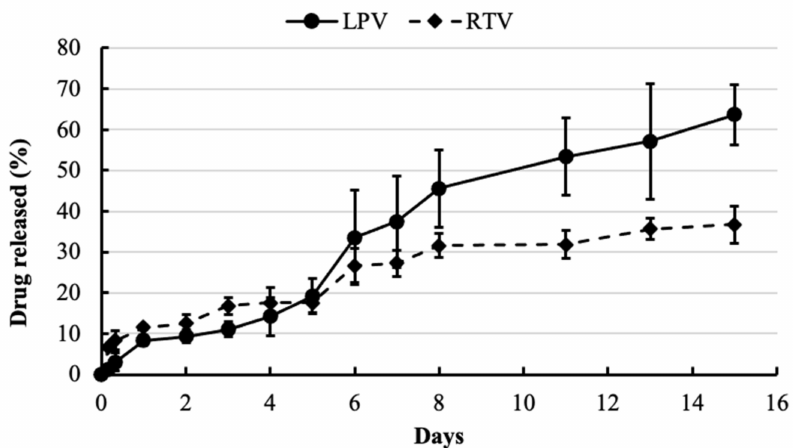
Table 2. RTV ( T 1/2 = 44.9 h) showed slower reduction of blood concentration compared to